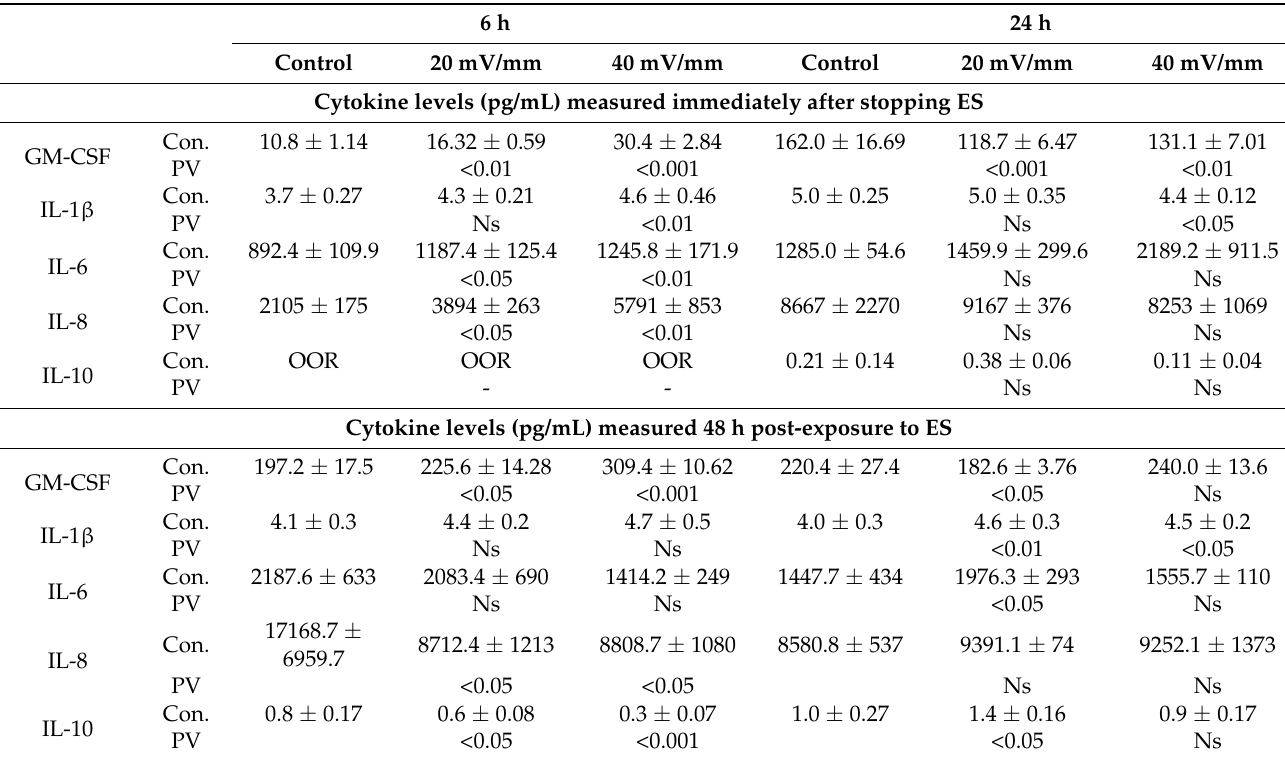
Table 1. Cytokine secretion by diabetic human skin fibroblasts after exposure or not to electrical stimulation. PV = p -value; Con. = Concentration; Ns = Not significant; OOR = Out of